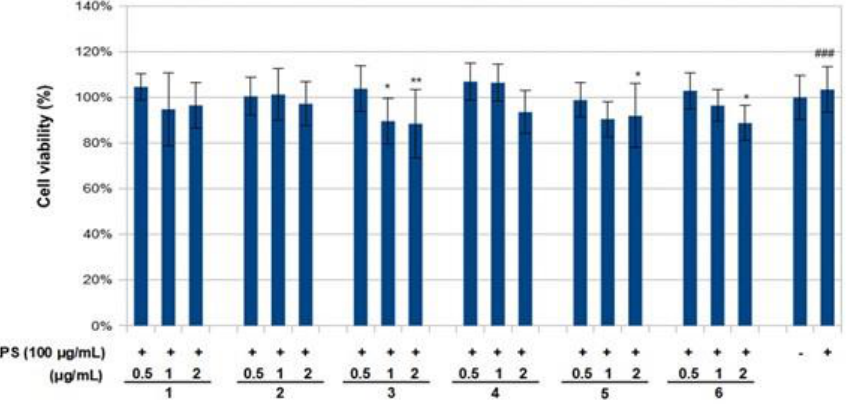
Figure 4. Effects of compounds 1 – 6 and lipopolysaccharide (LPS) on the viability of RAW 264.7 macrophages. Cells were treated with LPS for 6 h prior to treatment with indicated concentrations of compounds or LPS alone. Following a 24 h incubation period, cell viability was assessed using an